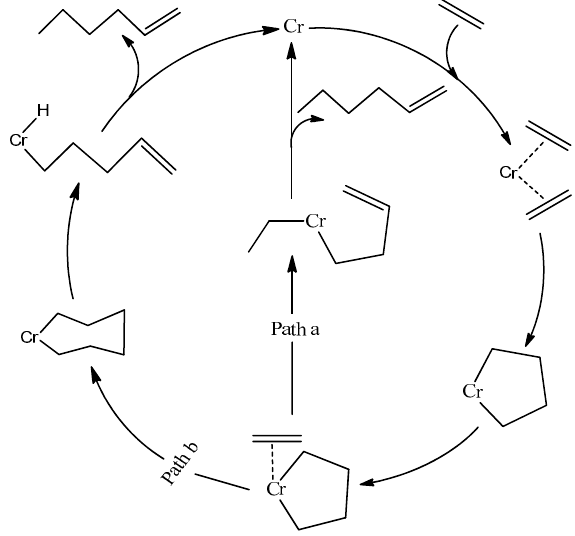
Figure 1. Proposed mechanism of ethylene trimerization.